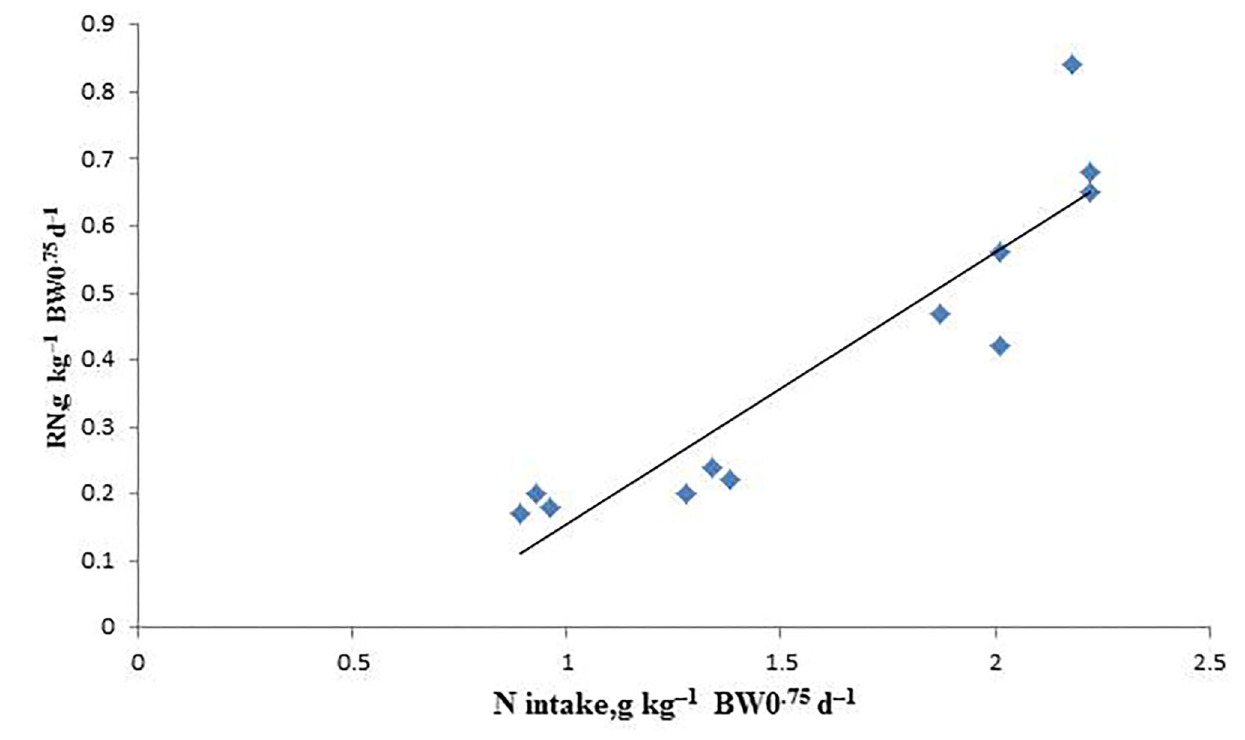
FIGURE 2 | The relationship between the retained nitrogen (RN) and nitrogen intake (NI) of arctic foxes in the indirect calorimetry method. RN = − 0.2518( ± 0.1352) + 0.407( ± 0.0524) × NI. R 2 = 0.8479, P < 0.001, n =